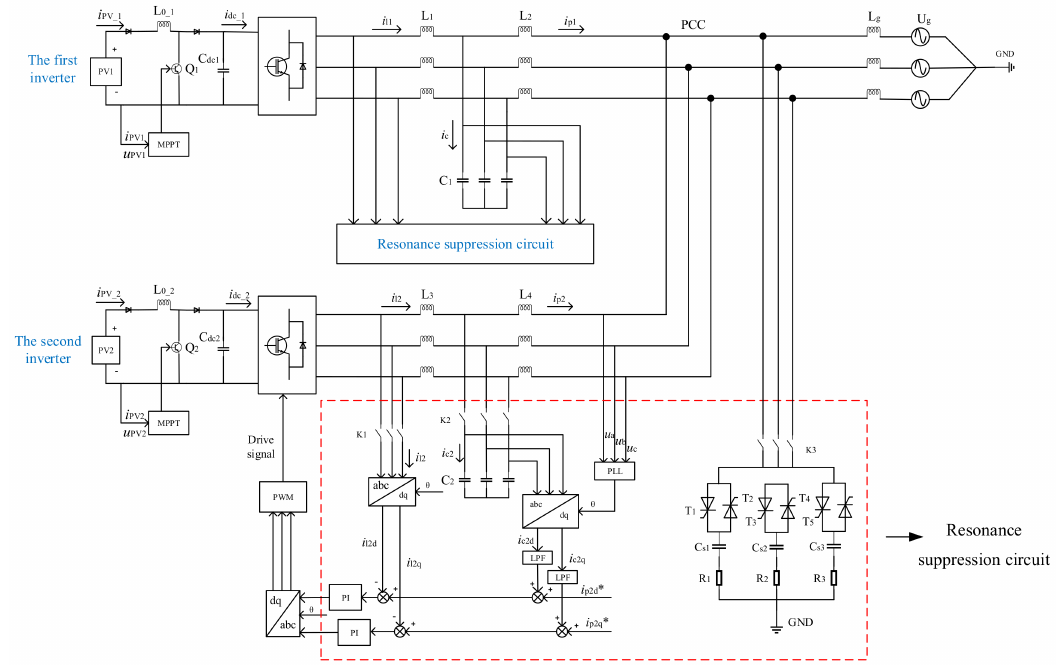
Figure 12. Two sets of photovoltaic cluster inverter system control schematic diagram.